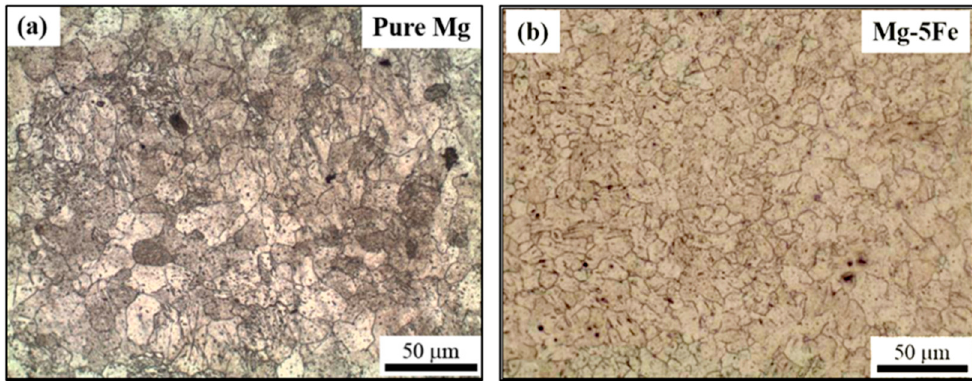
Figure 3. Optical micrographs of ( a ) pure Mg and ( b ) Mg-5Fe.